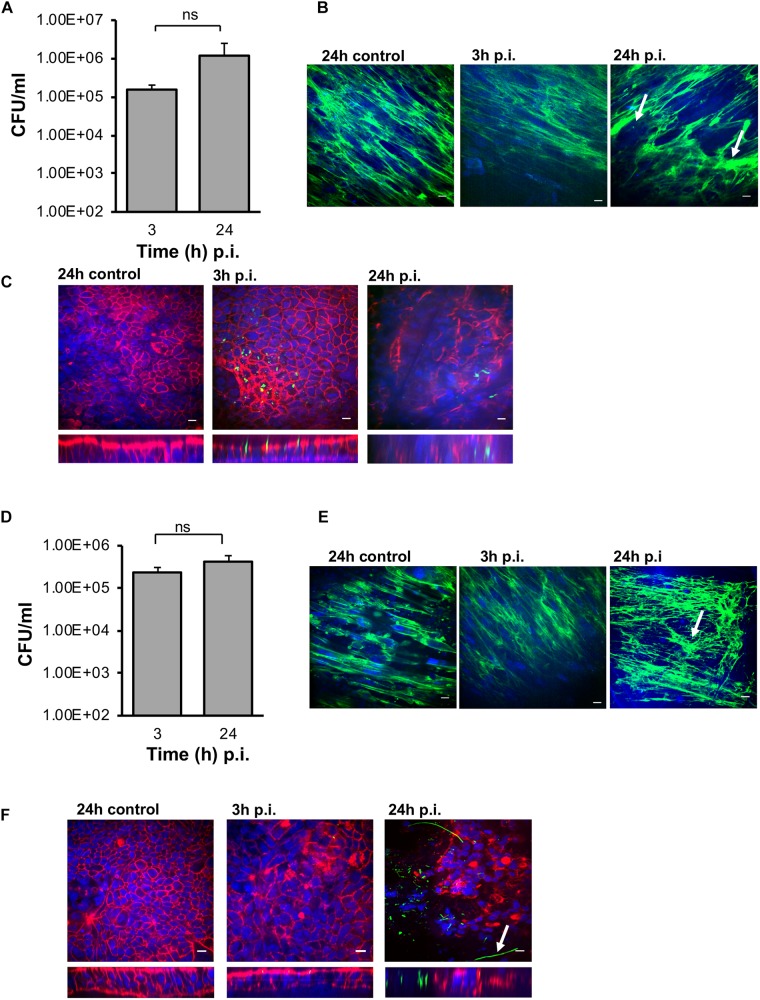
Infection of C. difficile in M-VDC and 3D-VDC model leads to increased adhesion. Increased adherence of C. difficile in the M-VDC and 3D-VDC models, where fibroblasts are grown as a basolateral layer on polyester and nanofibers, respectively. (A) Serial dilutions of the infected epithelial cell lysates were plated to determine the number of cell-associated bacteria (vegetative cells) in the M-VDC model. Data shown are the mean of three independent experiments and error bars indicate SD, ns, not significant as determined by student’s t-test. (B) Anti-fibronectin (green) staining of fibroblast cells in the basolateral layer of the control at 24 h p.i and infected cells at 3 and 24 h p.i. showing redistribution of fibronectin, damaged fibroblast layer in the M-VDC model, as indicated by a white arrow. (C) Representative images of C. difficile on the apical layer at 3 and 24 h p.i. Inset below shows the orthogonal XZ axis view of the IECs. C. difficile is stained green, actin, red, and cell nuclei, blue, scale bar = 10 μM. (D)
C. difficile colony counts (vegetative cells) from the 3D model infected cell lysates. Data shown are the mean of three independent experiments and error bars indicate SD, ns, not significant as determined by student’s t-test. (E) Anti-fibronectin (green) staining of fibroblast cells in the basolateral layer at 3 and 24 h p.i. (F) Immunofluorescent microscopy images of C. difficile infected IECs at 3 and 24 h p.i. in the 3D model. C. difficile filamentous forms are observed at 24 h p.i. (indicated by arrow). Inset below shows the orthogonal XZ axis view of the IECs. C. difficile is stained green, actin, red, and cell nuclei, blue, scale bar = 10 μM.